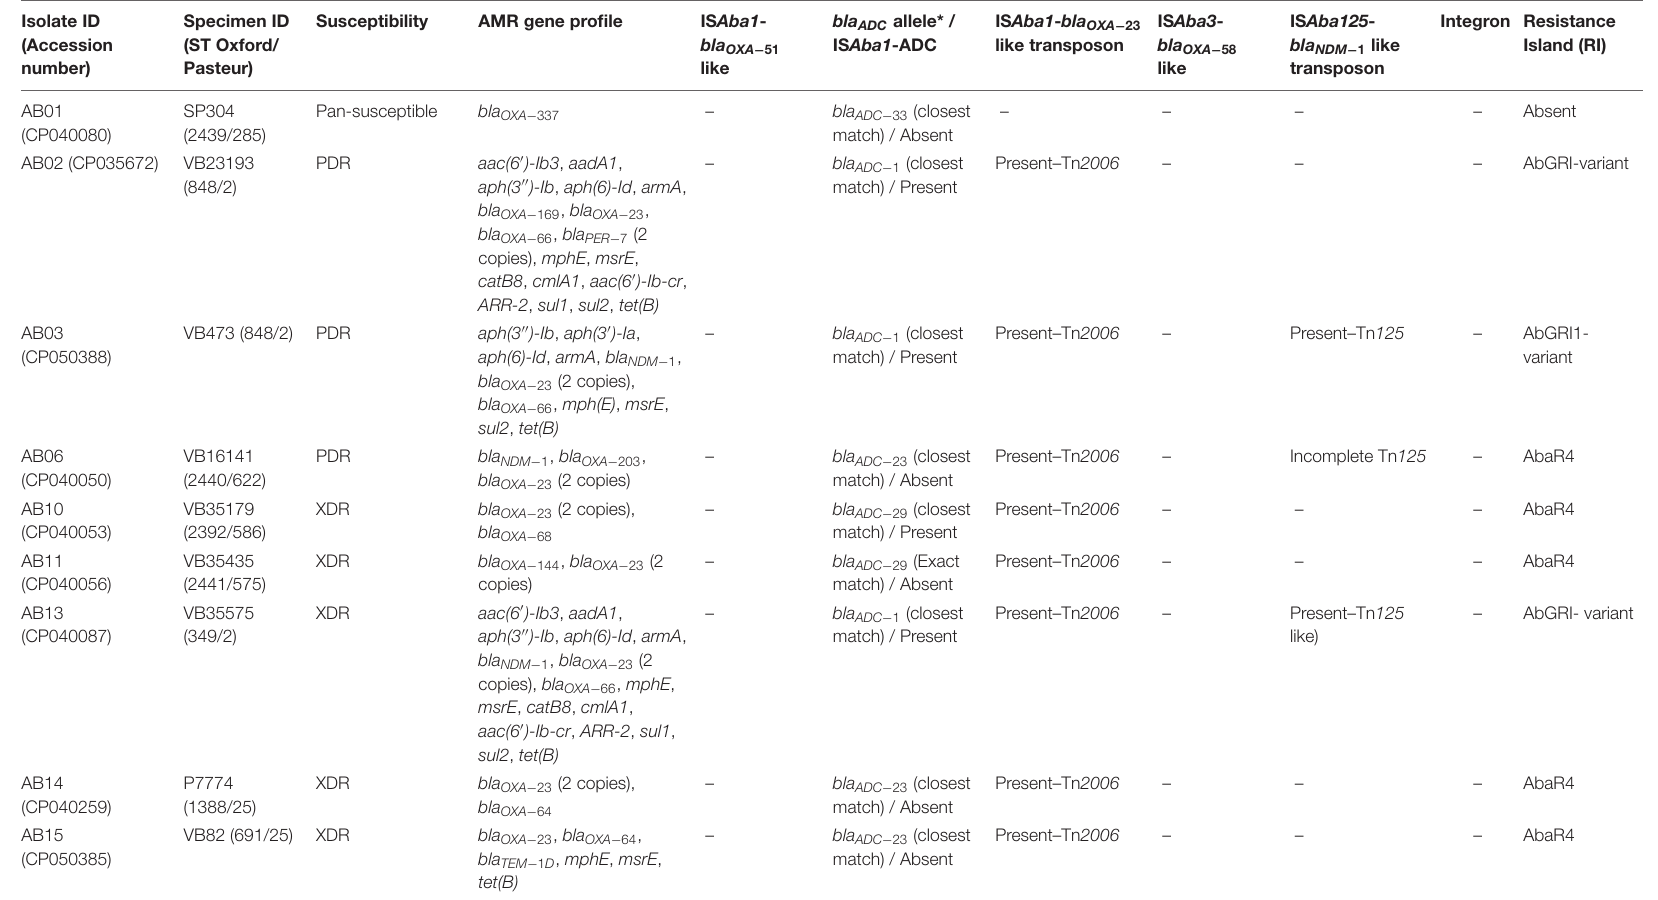
TABLE 2 | Presence of antimicrobial resistance (AMR) genes, mobile genetic elements, and resistance islands among the 17 complete genomes of Acinetobacter baumannii. Isolate ID